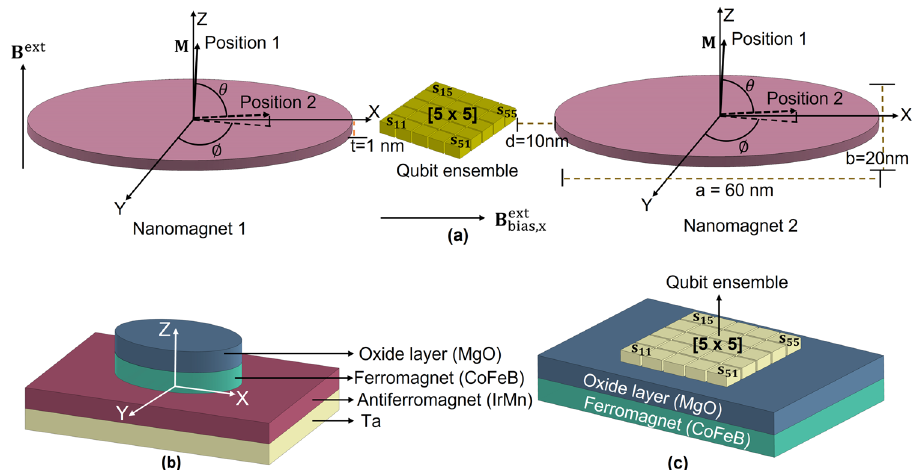
Fig. 1 Geometry (setup) of nanomagnets and qubits. a Schematic diagram of simulation setup in MuMax3. b Schematic of nanomagnet layers. Ferromagnet/antiferromagnet interface creates exchange bias fi eld ( B ext ) along the + x direction in the nanomagnet. The fi eld deterministically oscillates bias ; x from + z to + x when voltage-controlled magnetic anisotropy (VCMA) is applied in an external bias fi eld ( B ext ) of 0.3 T. c Schematic of qubit layers. Ferromagnet/Oxide interface to create perpendicular magnetic anisotropy (PMA) in the fi lm (magnetized along − z ) below the qubit volume. This fi eld partially offsets the external fi eld so the effective fi eld along + z seen by the qubit produces Larmor precession at 0.5 GHz (or 2 GHz). (Drawings are not to scale).